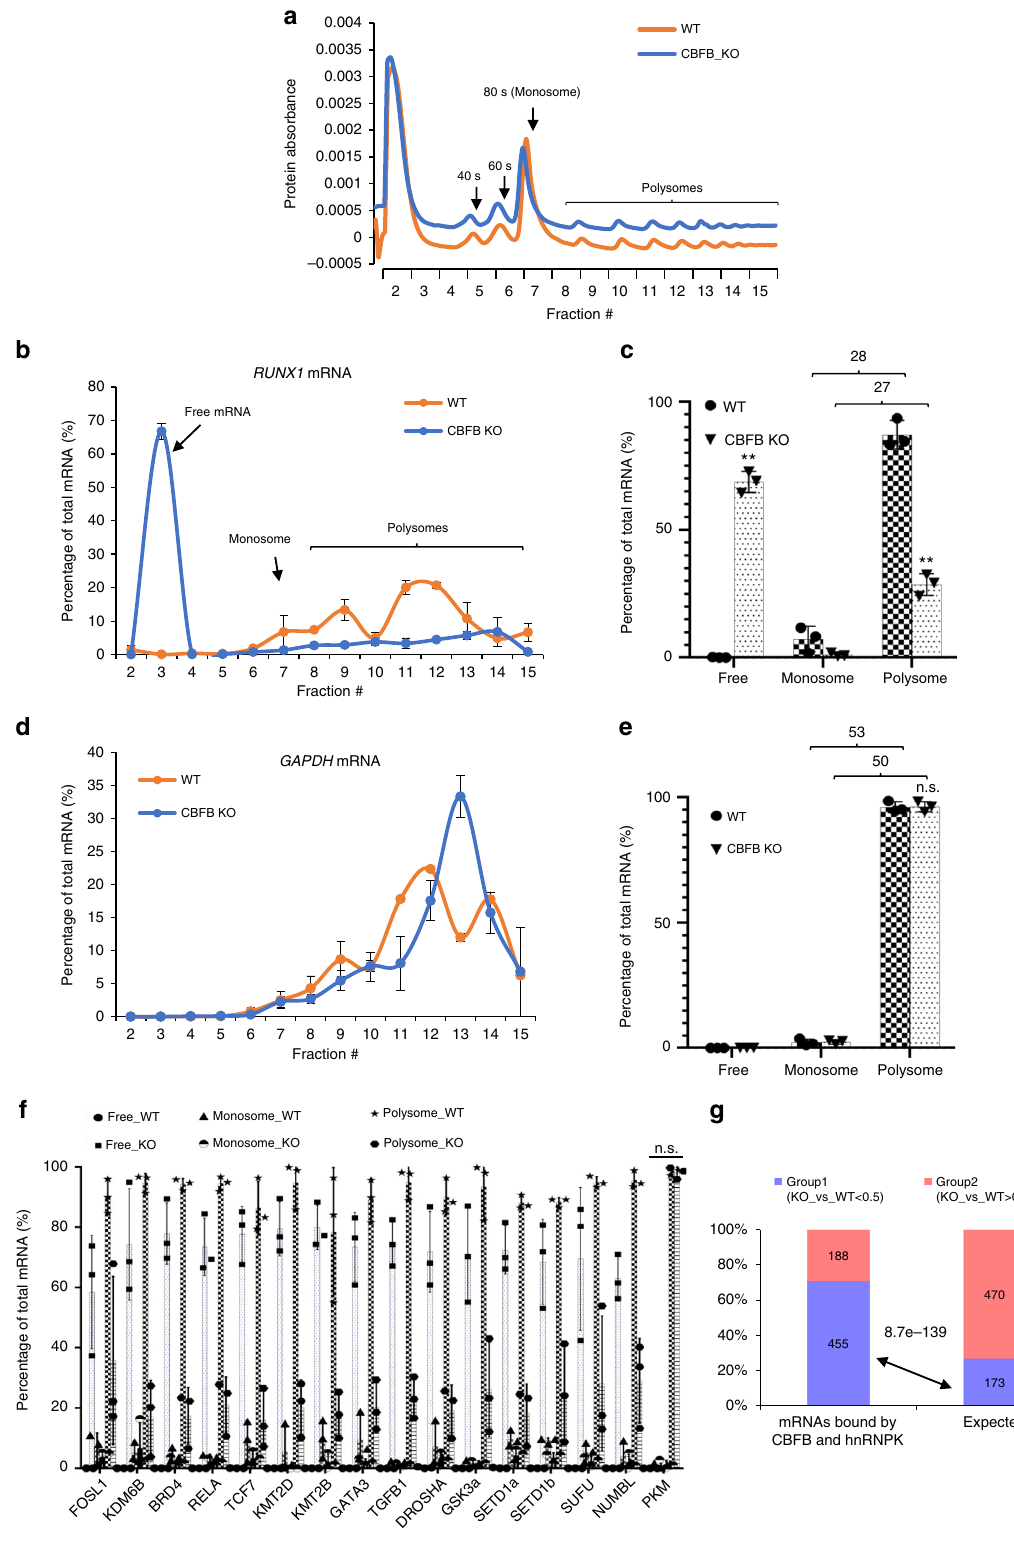
CBFB regulates translation initiation through eIF4B . To fur- ther investigate the underlying mechanism of CBFB-regulated translation initiation, we searched for translation related factors in identi fi ed CBFB interacting proteins (Fig. 2a) and detected eukaryotic initiation factor 4B (eIF4B) as a potential